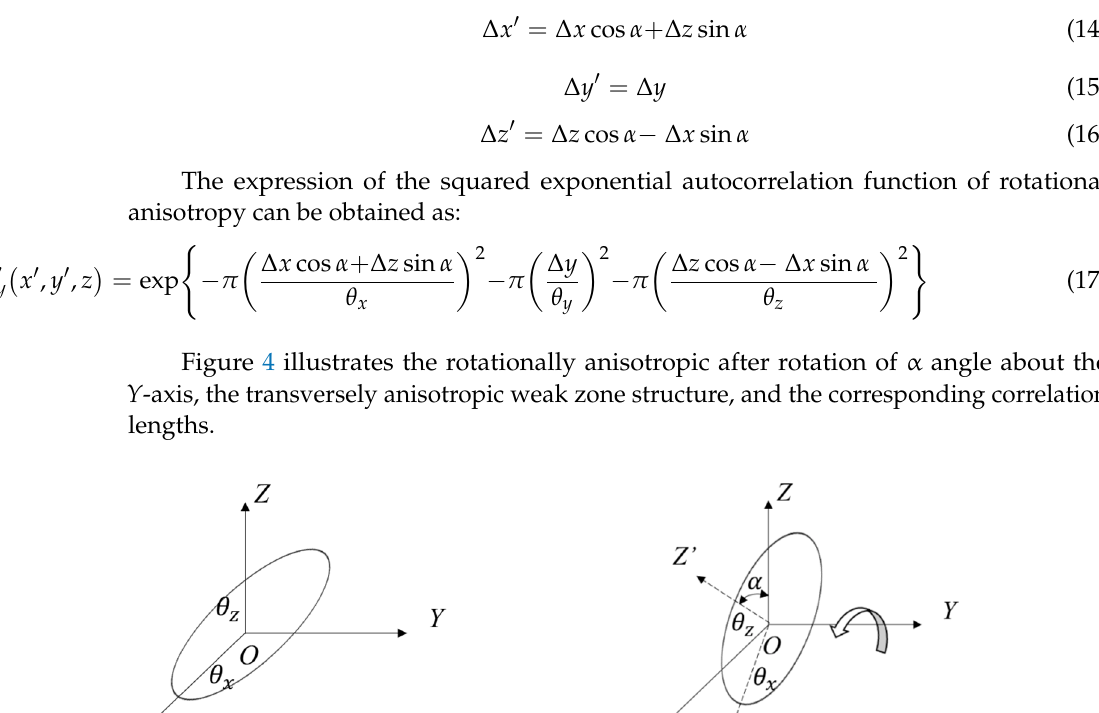
Figure 3. Correlation structure of different related structures. ( a ) Horizontal rock slope; ( b ) schematic diagram of the cor- relation length of the x = 0; ( c ) rotational anisotropic slope; ( d ) correlation length of rotational anisotropy after rotation of the α angle about the X -axis.